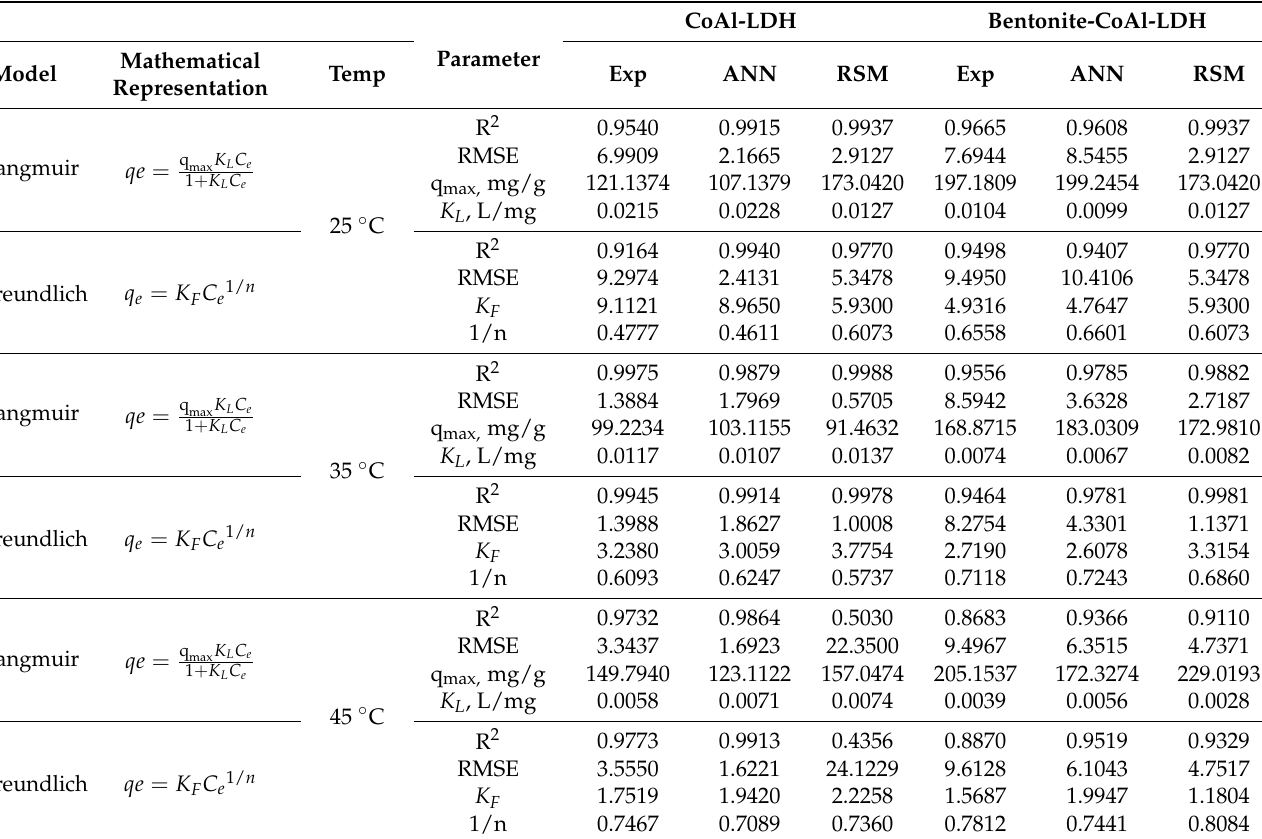
Table 8. Non-linear equilibrium model fitting parameters CoAl-LDH and bentonite-CoAl-LDH for Cr(VI)